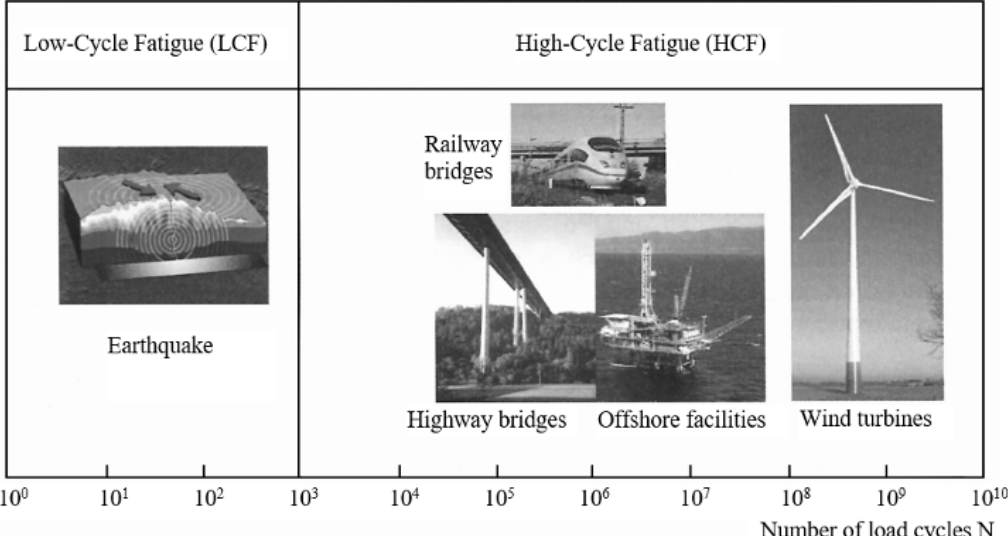
Figure 1. Number of load cycles of di ff erent cyclically stressed structures [1].